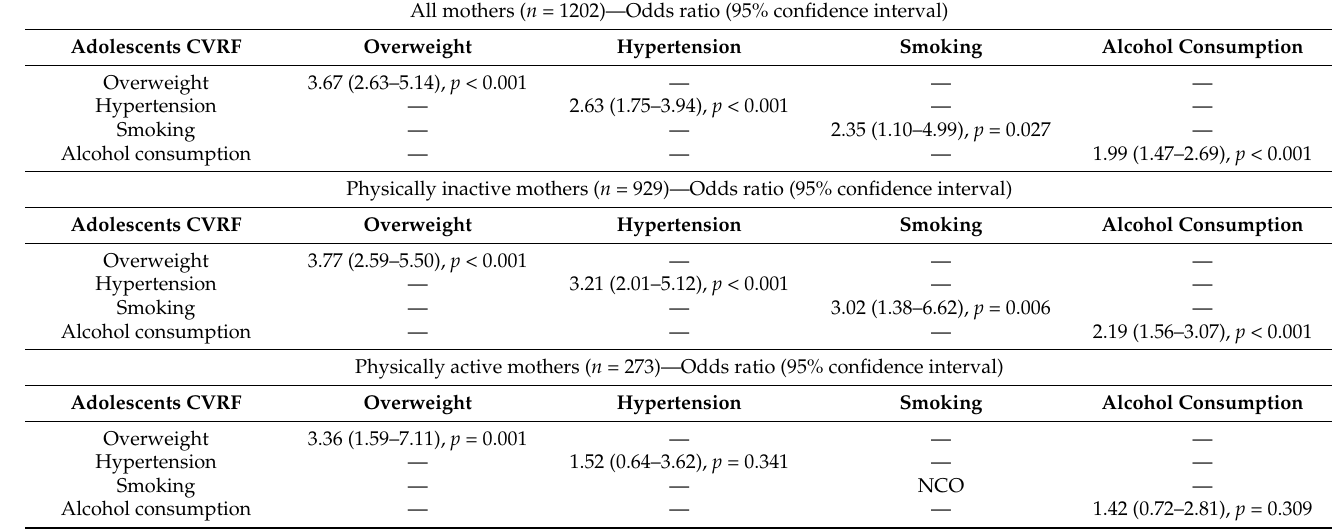
Table 2. Association between the presence of cardiovascular risk factors in mothers and in their children according to the physical activity level of mothers.